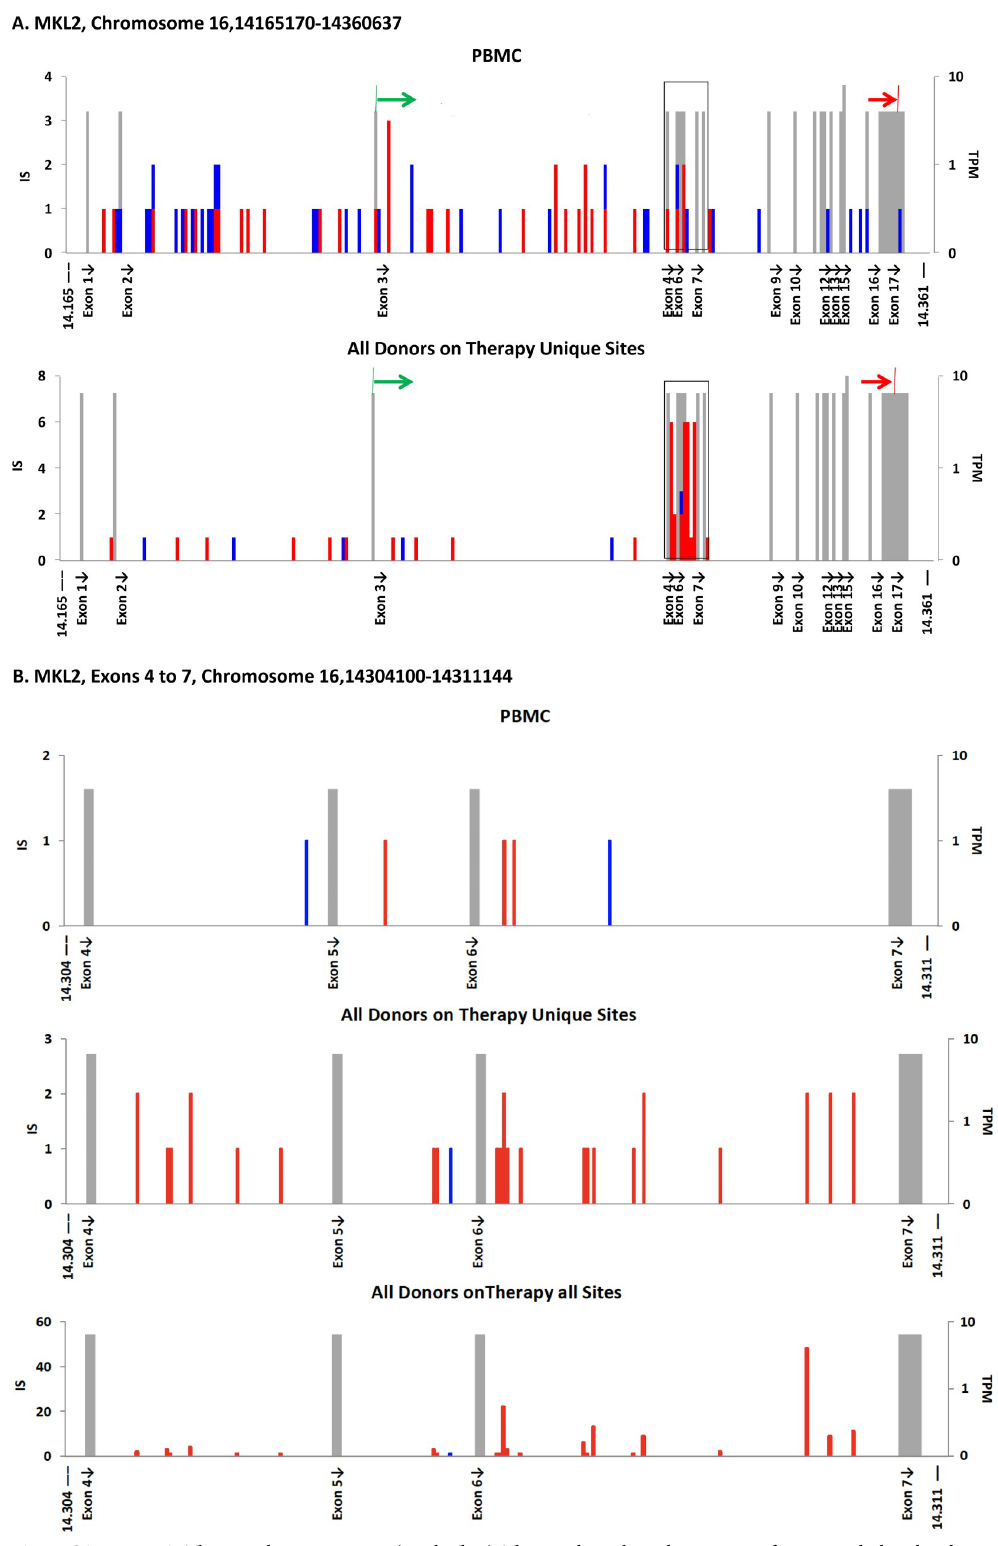
Fig 4. IS in MKL2 A. The complete MKL2 gene (308 bp/bin). The gray bars show the position of exons, with their height indicating the expression level of the gene in TPM, as in Fig 3. The protein coding region is indicated by the colored